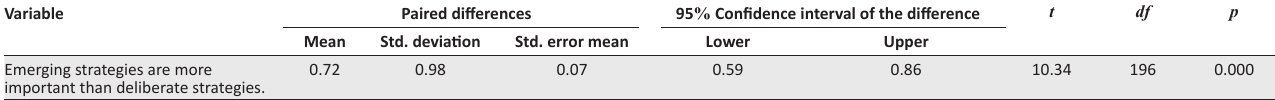
TABLE 4: Results of the paired samples t -test for differences in mean scores of emergent strategy and deliberate strategy. Variable Paired differences 95 % Confidence interval of the difference t df p Mean Std. deviation Std. error mean Lower Upper Emerging strategies are more important than deliberate strategies.